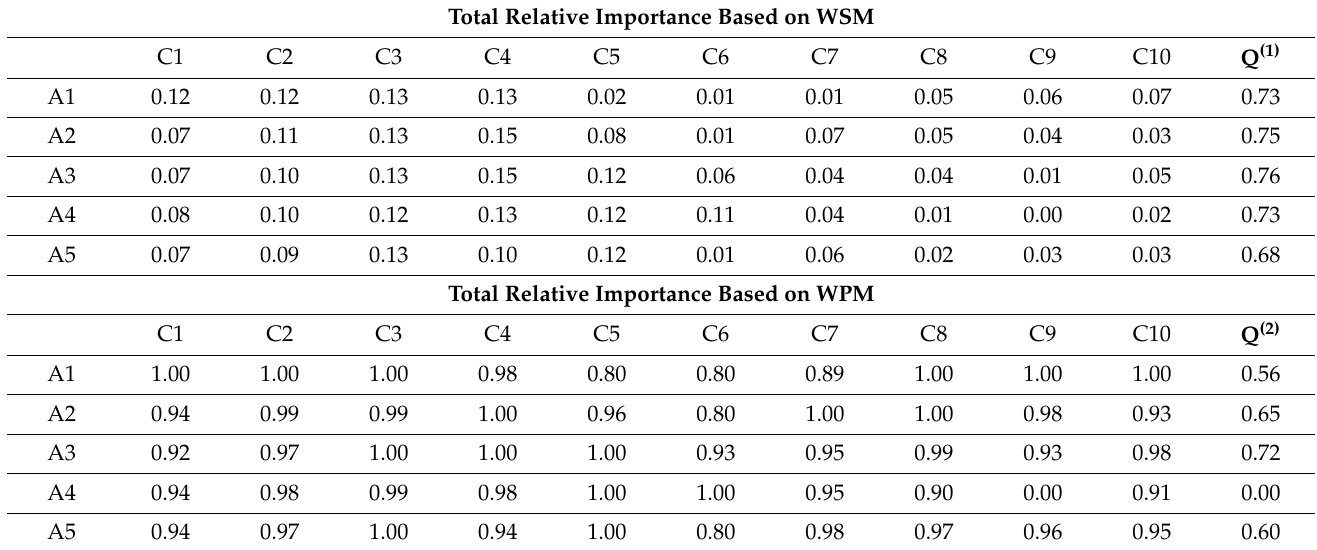
Table 15. Determining the total relative importance based on WSM and WPM.